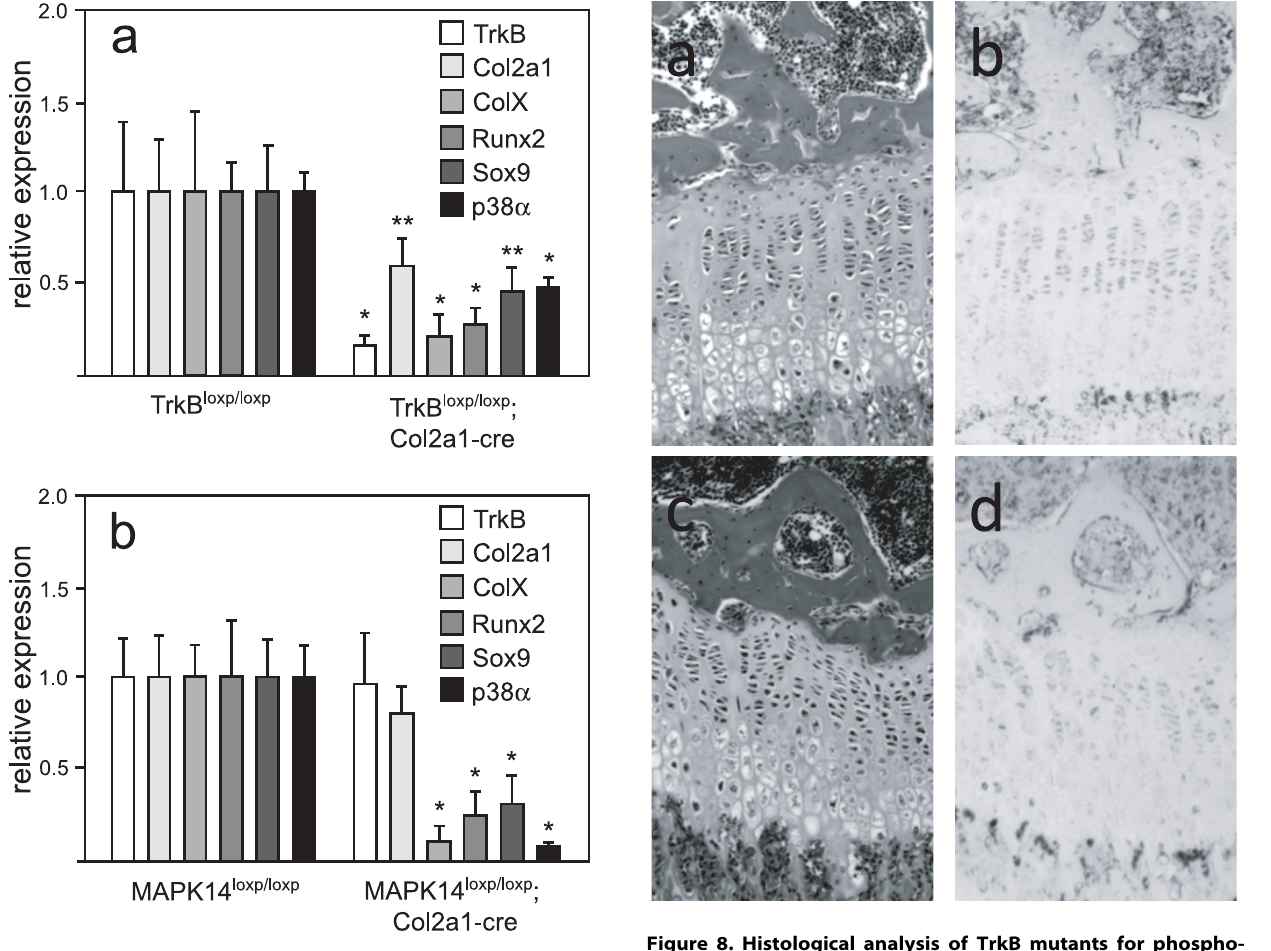
Figure 7. Expression of Runx2 and Sox9 in the growth plates of mutant mice. The growth plates from the proximal tibias of mutant and control littermates at day 7 after birth were dissected under a microscope, and isolated RNA analyzed by real time RT PCR for the expression of the two transcription factors as well as Col2a1, ColX, TrkB, and p38 a . A, TrkB mutants compared to control littermates; B, p38 a mutants compared to control littermates. Data points represent the mean 6 SD of six samples, expressed as fold difference from control samples (calibrator); *, P , 0.001, **, P , 0.01.